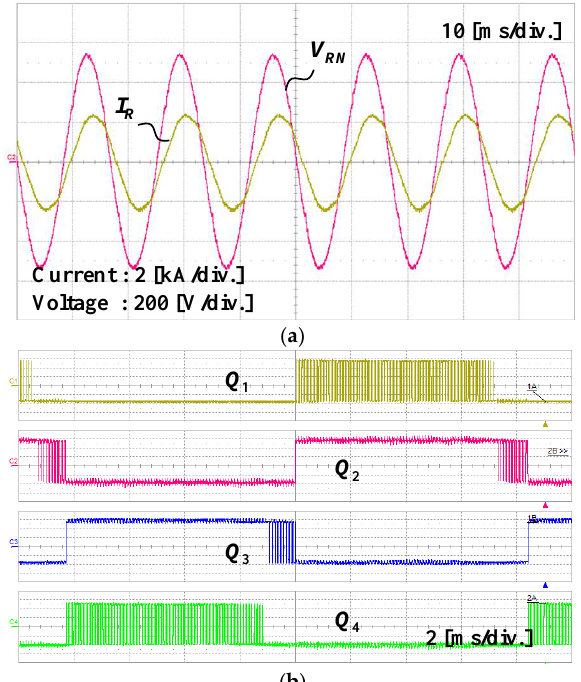
Figure 18. Experimental results in the case where the power factor is controlled at −0.9 (lead) using the proposed switching scheme: ( a ) waveforms of the output voltage and current; ( b ) waveforms of the gate signal.